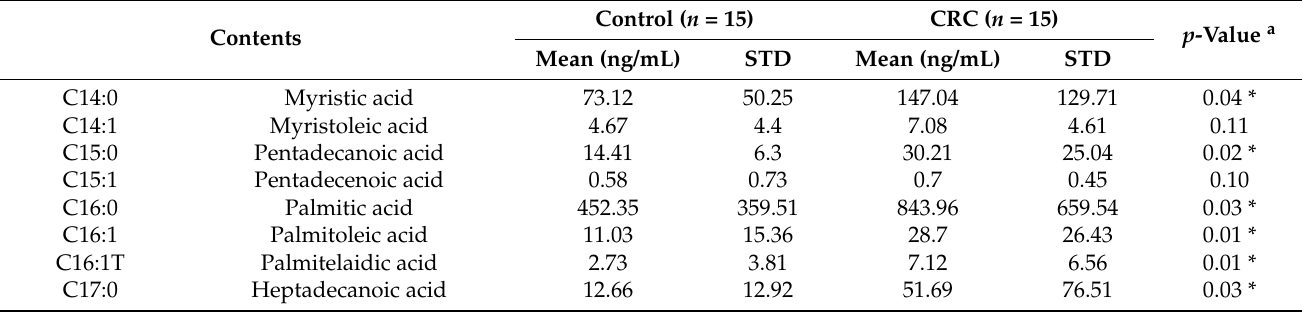
Table 3. Comparison of 32 fatty acid levels between controls and